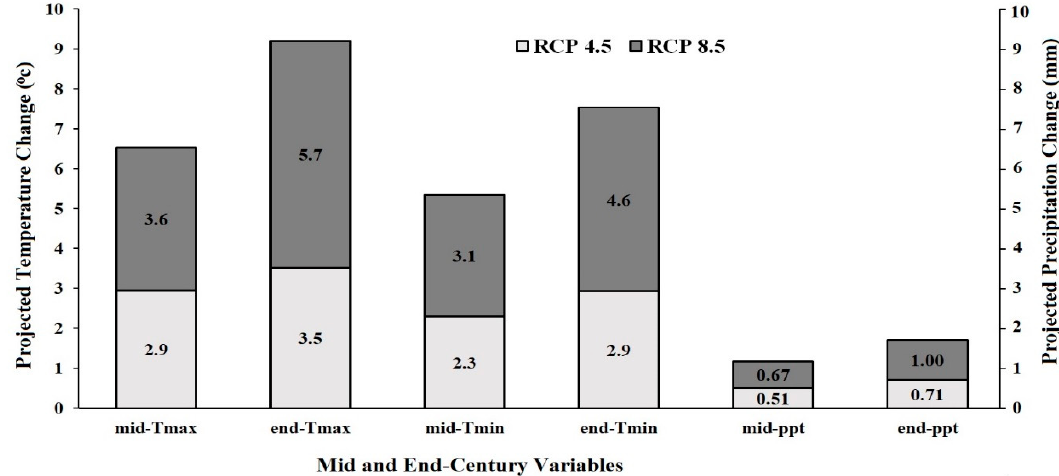
Figure 4. Average projected precipitation and temperature change for the 10 global climate models (GCMs) from baseline (1993–2018) for 2046–2065 mid-century (MC) and 2081–2099 end-century (EC) under the representative concentration pathways (RCP) 4.5 and RCP 8.5 scenarios.